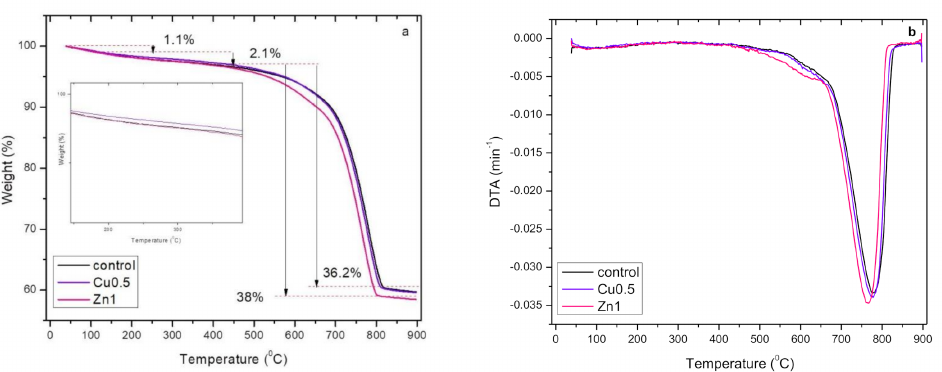
Figure 9. ( a ) Thermogravimetric (TG) analysis of GWC IP embedded with 0.5% CuO and 1% ZnO NPs; ( b ) DTA: derivative thermogravimetric analysis, the ratio of mass loss rate of sample to initial mass (min − 1 ) measured.